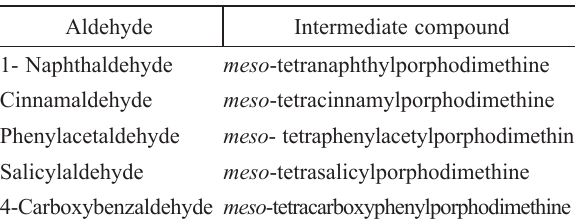
Table 1 – Aldehydes used and the corresponding intermedi- ate compounds